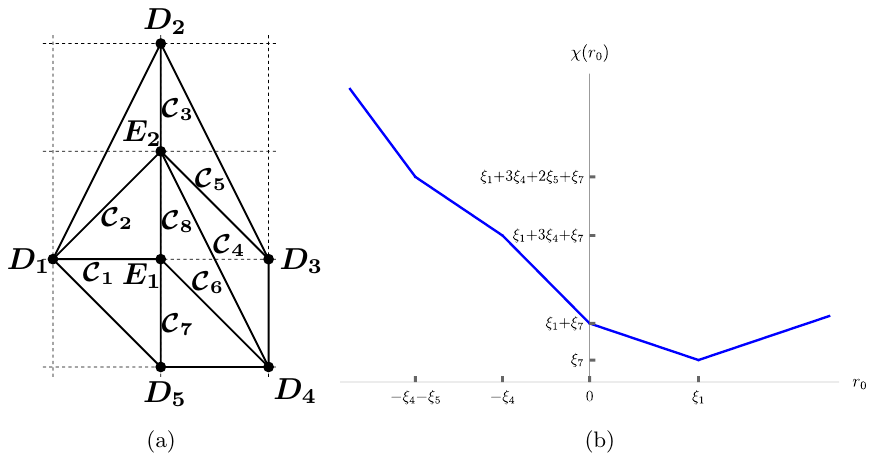
Figure 13 . Resolution (b) of the E 22 ; 3 2 singularity and its vertical